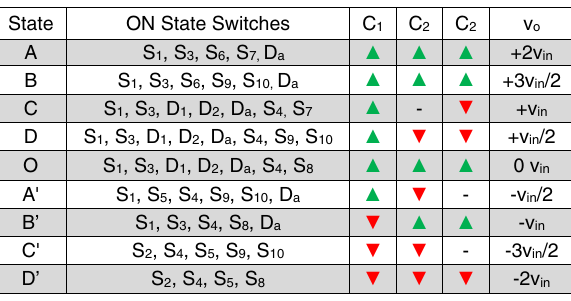
Table 1. Switching sequence for proposed TL-9L inverter.